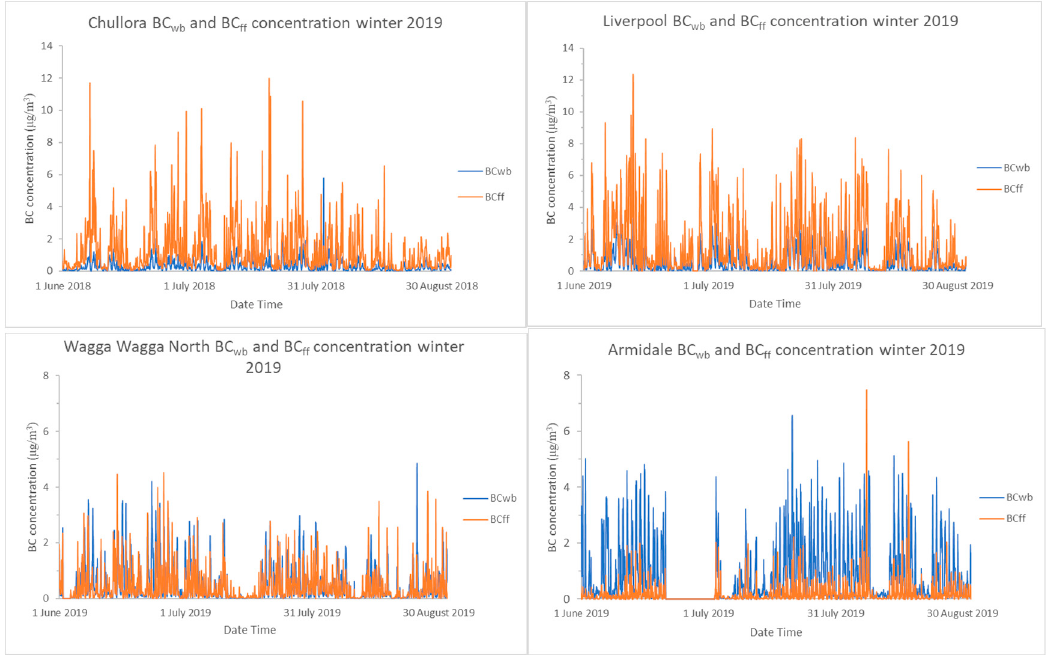
Figure 6. BC concentration from biomass burnings (wood heating) (BC wb ) and from fossil fuel combustion (BC ff ) at Chullora, Liverpool, Wagga Wagga North and Armidale during winter 2019.